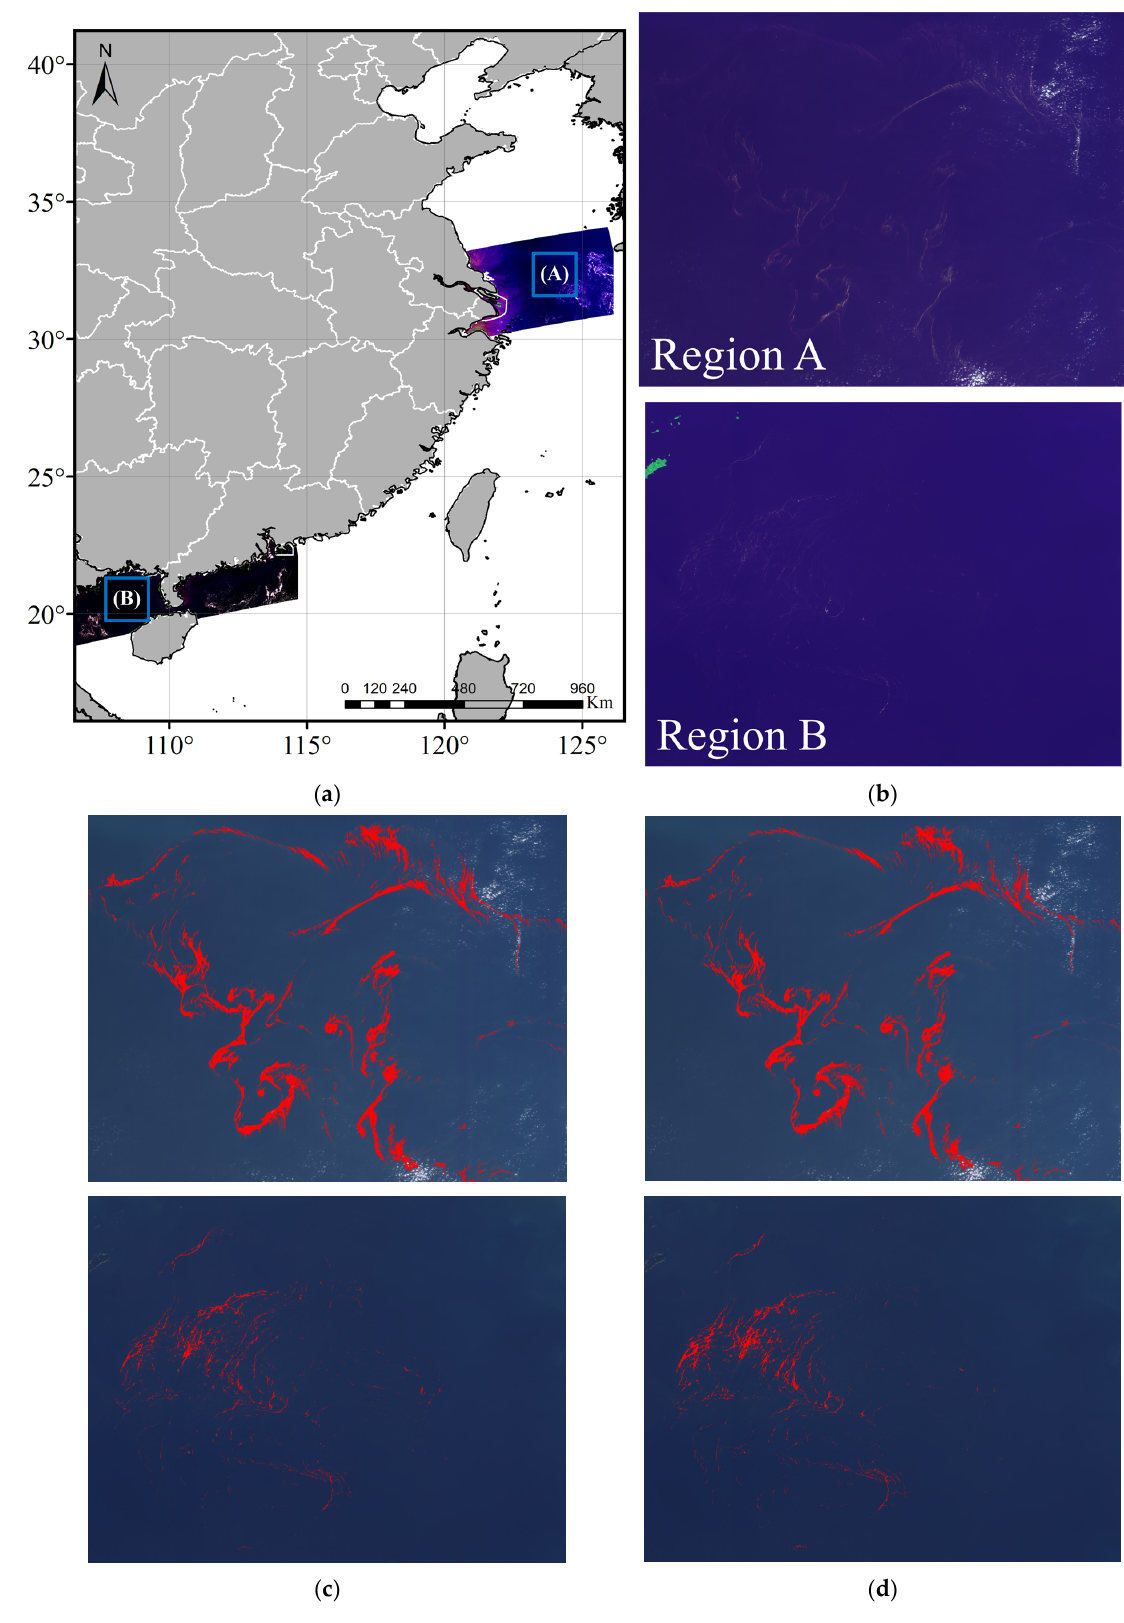
Figure 11. CZI NSB validation result. ( a ) Region; ( b ) FRGB; ( c ) ground truth; ( d ) NSBRNet.